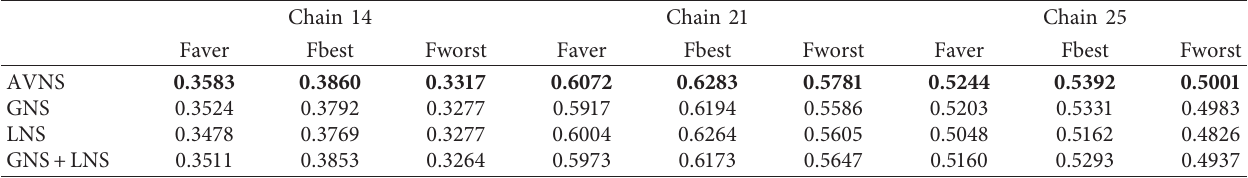
Figure 12: Fitness curve comparison between AVNS, GNS, LNS, and GNS+LNS: reconfiguring (a) chain 14, (b) chain 21, and (c) chain 25 by adding f a � 5% edges. Table 5: Performance comparison of four neighborhood searching